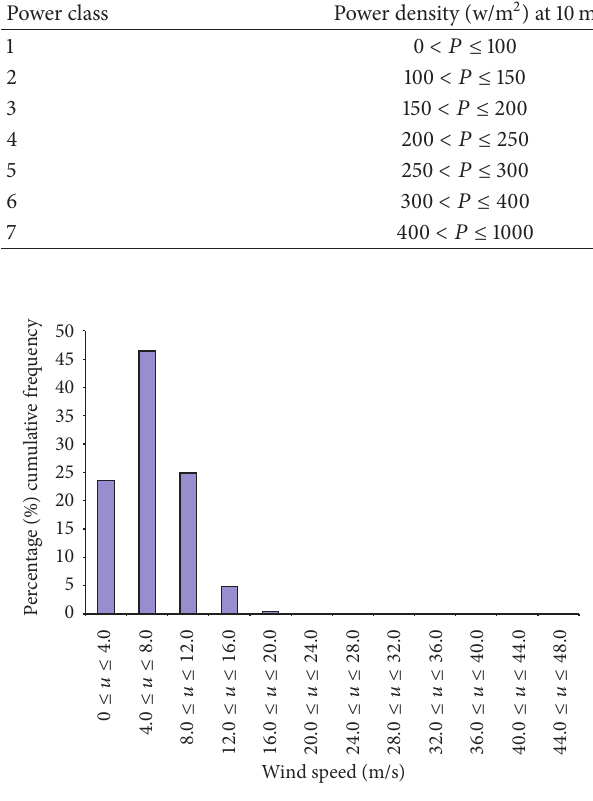
Figure 6: The percentage frequency distribution of wind speed obtained from the thirty-year (1980–2009) daily average wind speed data of ECS, unit: %.